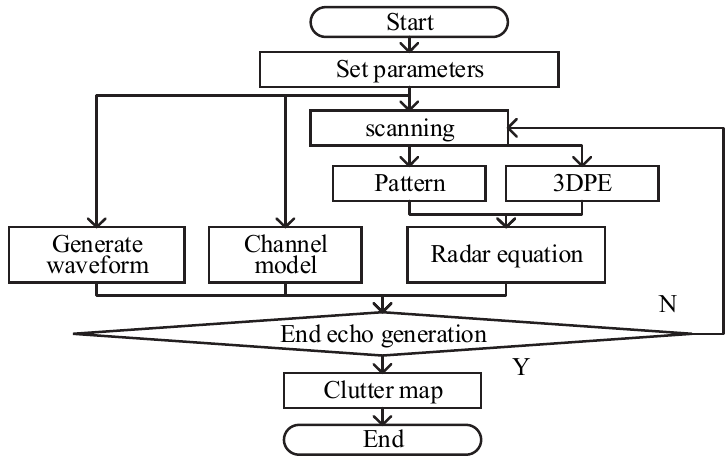
Figure 1. The workflow chart of the proposed simulation scheme.